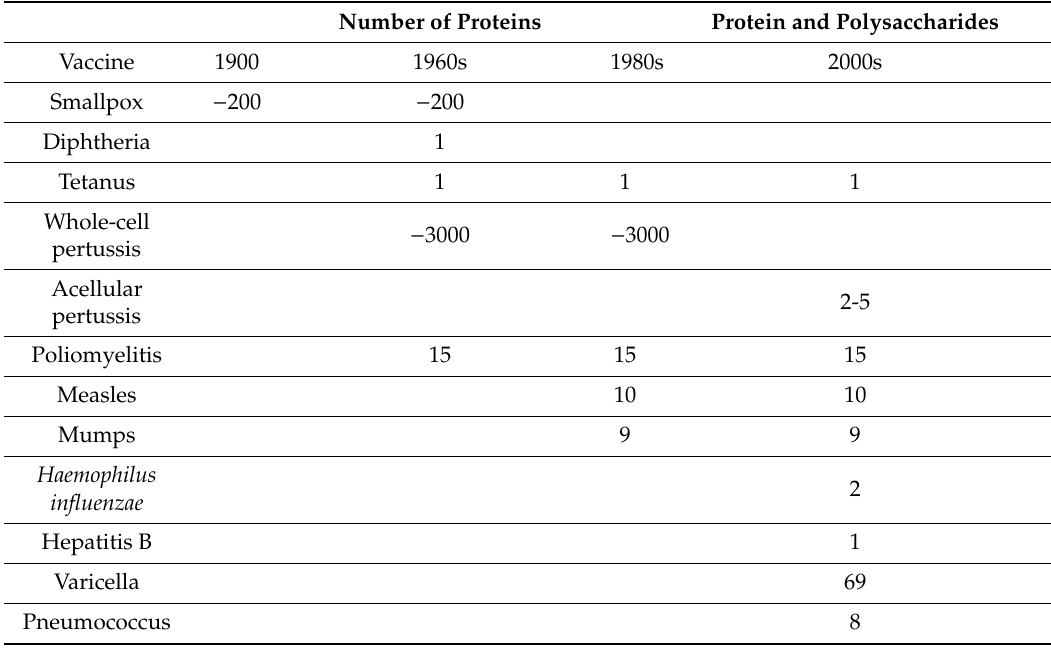
Table 1. Number of immunogenic pathogens / polysaccharides in vaccines over the past 100 years. Number of Proteins Protein and Polysaccharides Vaccine 1900 1960s 1980s